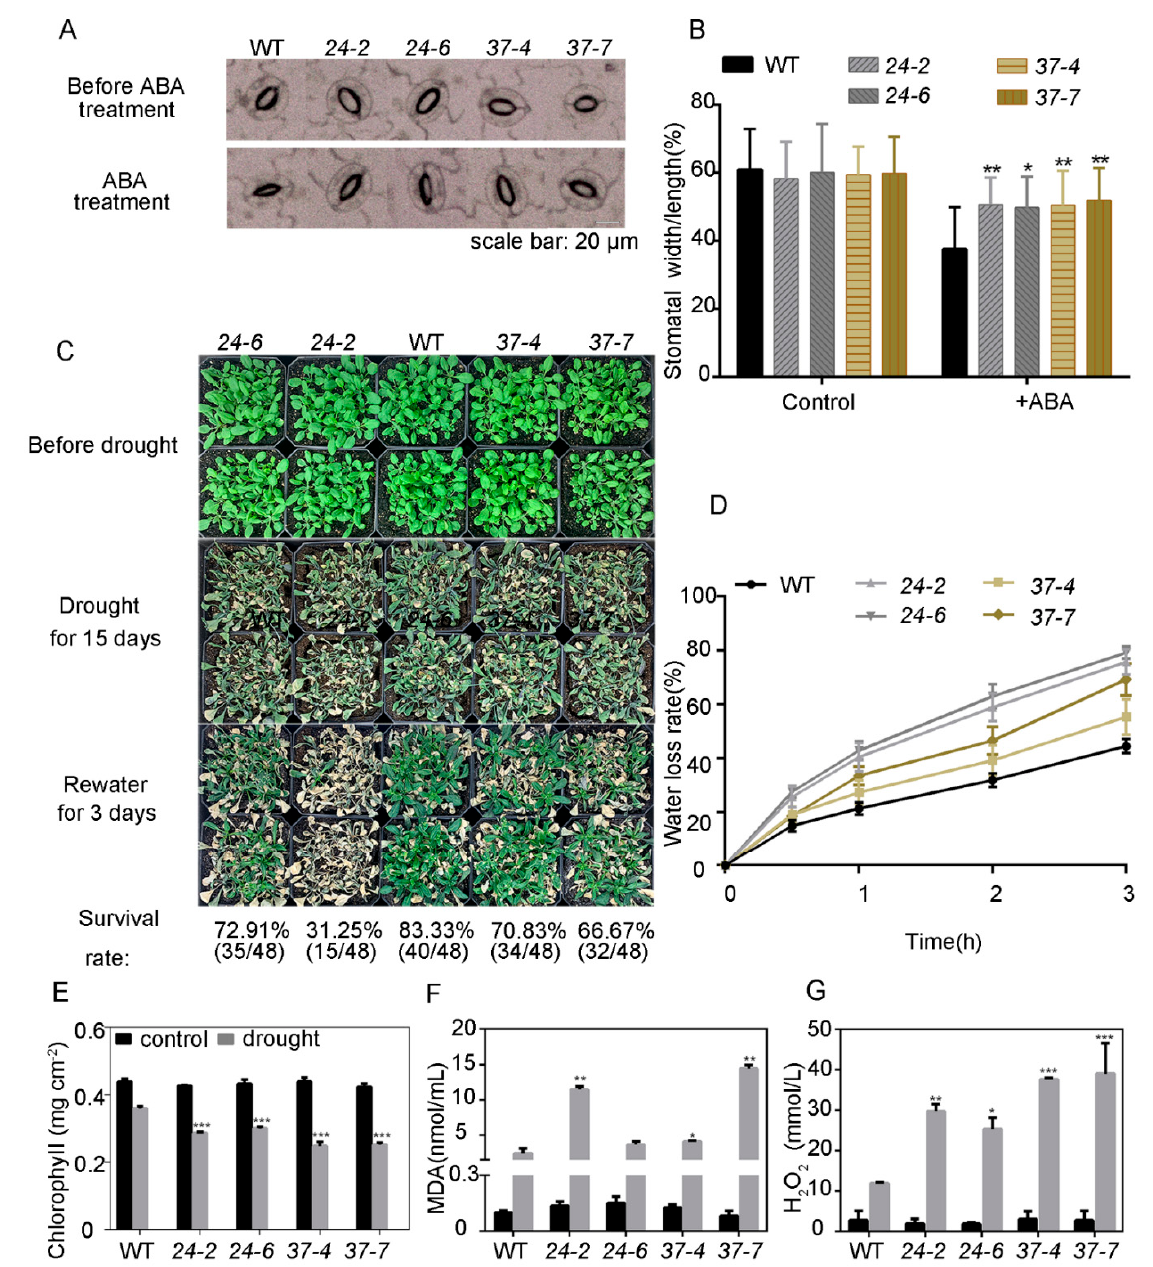
Figure 4. The MdPP2C24/37 overexpression lines in Arabidopsis displayed decreased drought stress tolerance compared to WT. ( A , B ) Stomatal aperture assay induced by ABA of MdPP2C24/37 overexpression lines in Arabidopsis . ( A ) Representative images of stomatal aperture and ( B ) statistical analysis of stomatal aperture width/length. Values represent the mean ± SD from three independent experiments; n = 80 per experiment. ( C ) Drought tolerance assay of WT and MdPP2C24/37 overexpression lines. Three-week-old plants were exposed to drought stress for 15 days and then rewatered for three days. Values represent the mean ± SD from three independent experiments; n = 48 per experiment. ( D ) Water loss rates during 3 h period in detached leaves of WT and MdPP2C24/37 overexpression lines. Values represent the mean ± SD of five individual plants per genotype. ( E – G ) Plants of all genotypes subjected to drought through withholding of water for 12 days. ( E ) Chlorophyll ( F ) MDA, and ( G ) H 2 O 2 levels were measured. Results represent the mean ± SD from three inde- pendent experiments, with similar results obtained. Values were significantly different from WT at * p < 0.05, ** p < 0.01 or *** p <